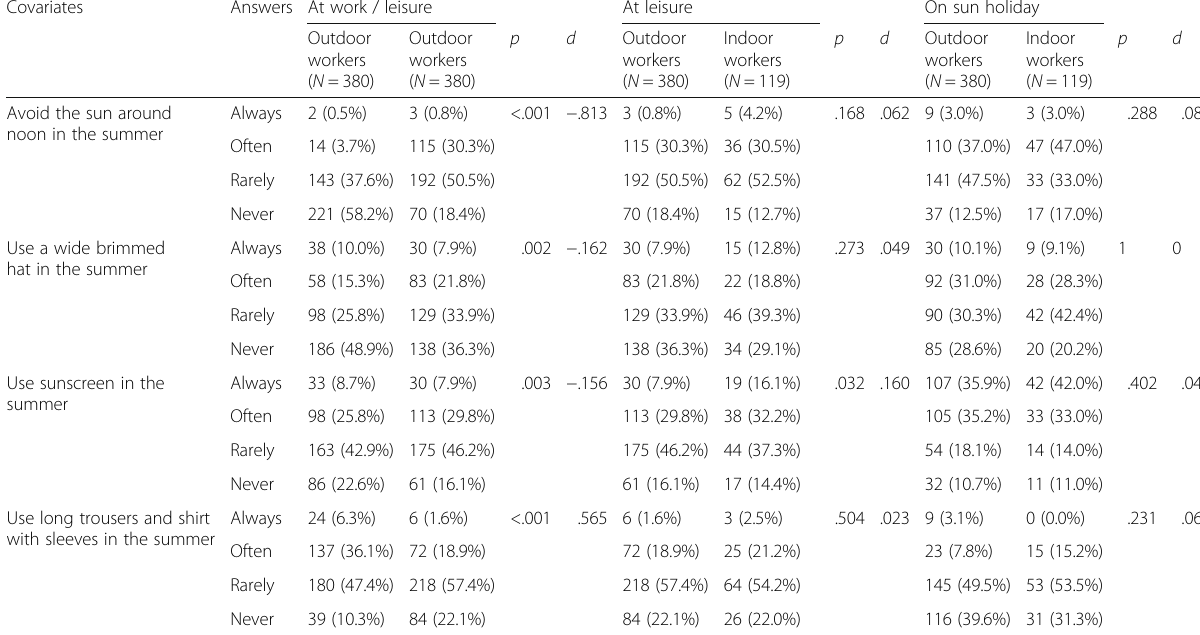
Table 3 Sun protective behavior at work, at leisure and on sun holidays Covariates Answers At work / leisure At